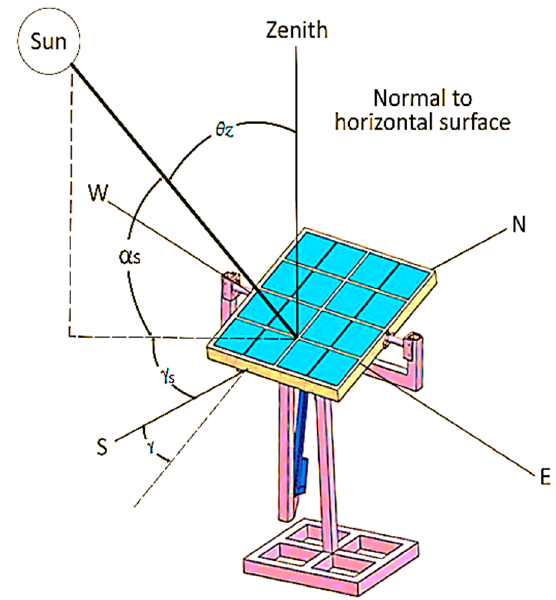
Figure 2. The direction of beam radiation.